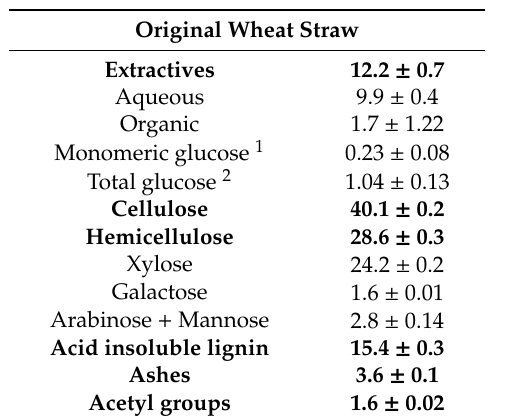
Table 3. Composition of the wheat straw samples with respect to the dry